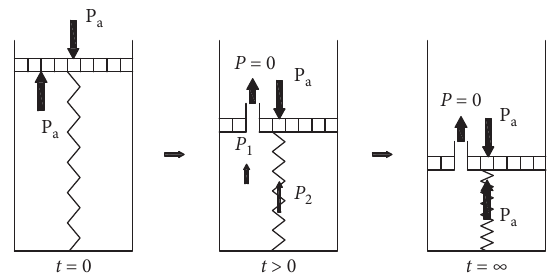
Figure 3: Spring piston model of vacuum preloading drainage consolidation [17].